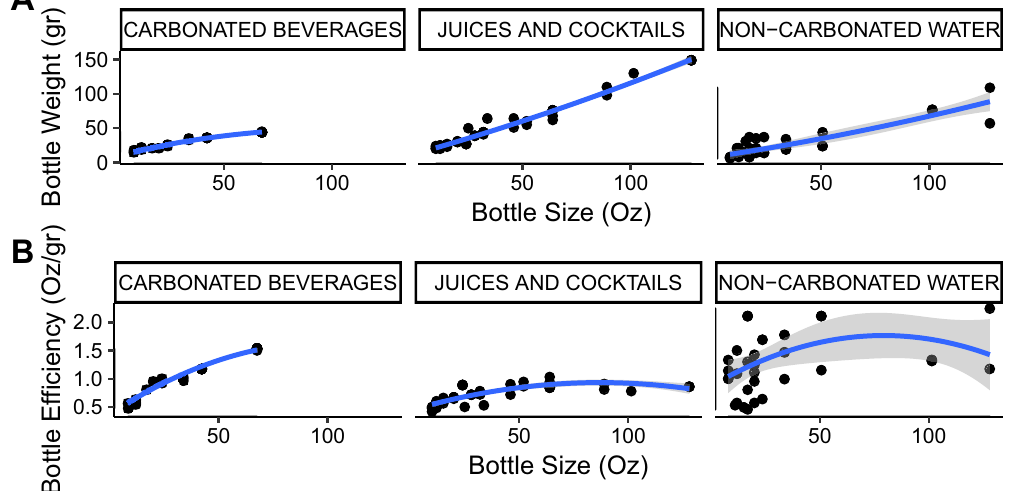
Figure 2. Relationships between bottle capacity and weight (A) , and between bottle capacity and efficiency (B) by beverage category ( n = 187). The blue line represents the best quadratic approximation and the gray envelope its standard error.